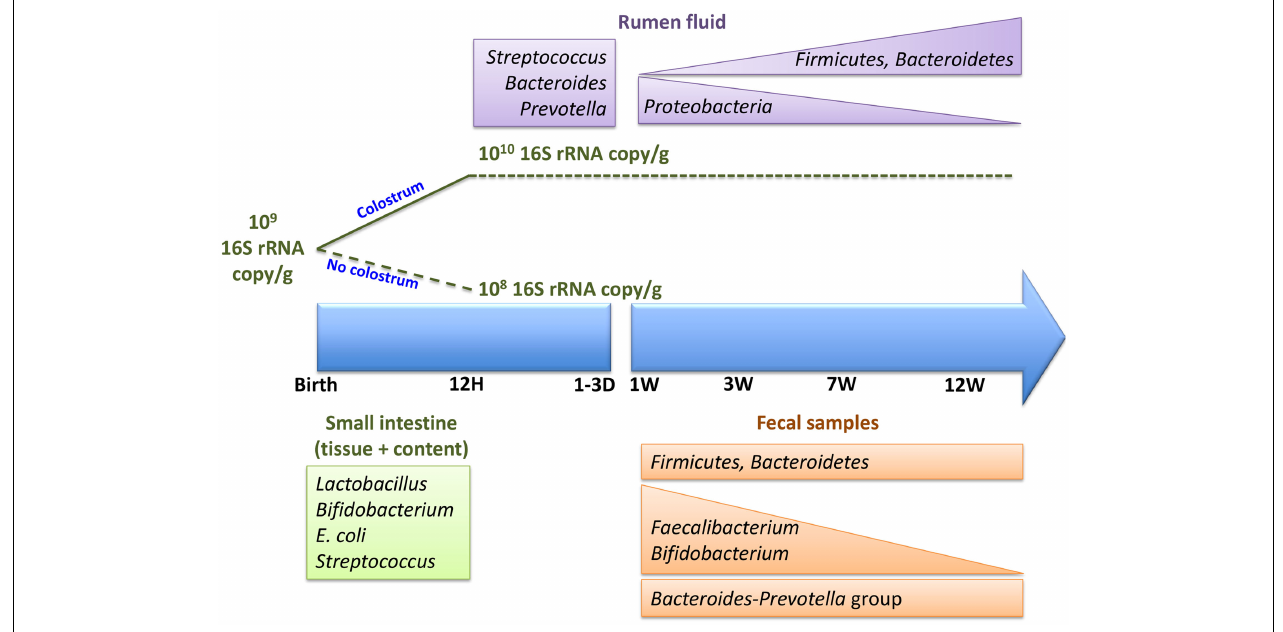
FIGURE 2 | Colonization of neonatal calf rumen/gut, immediately postpartum and within the first 12weeks of life